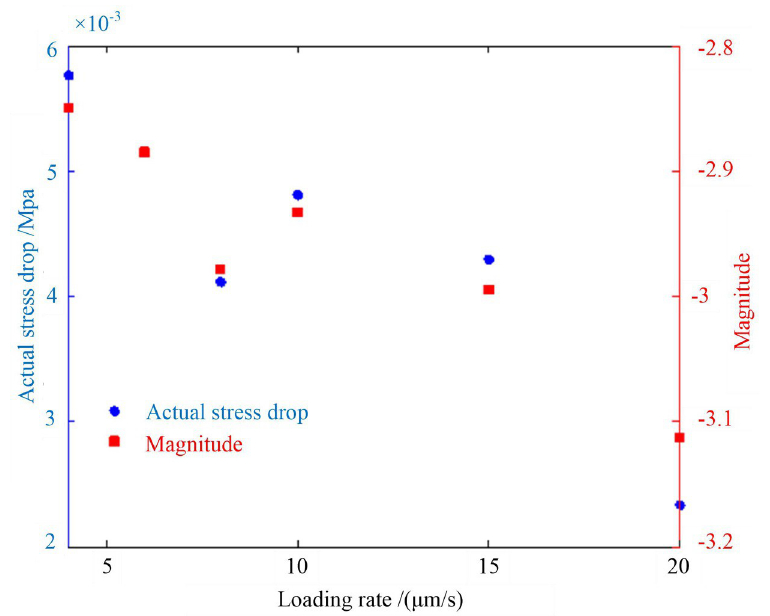
Fig 10. Magnitude and actual stress drop responses to the loading